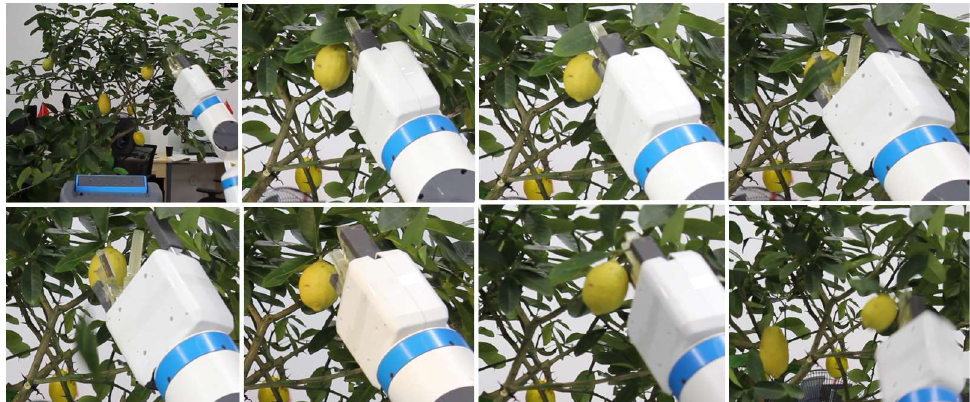
Figure 15. Video frames for the modified scenario in which the robot picked an occluded lemon (bottom) by removing an occluding leaf (top).